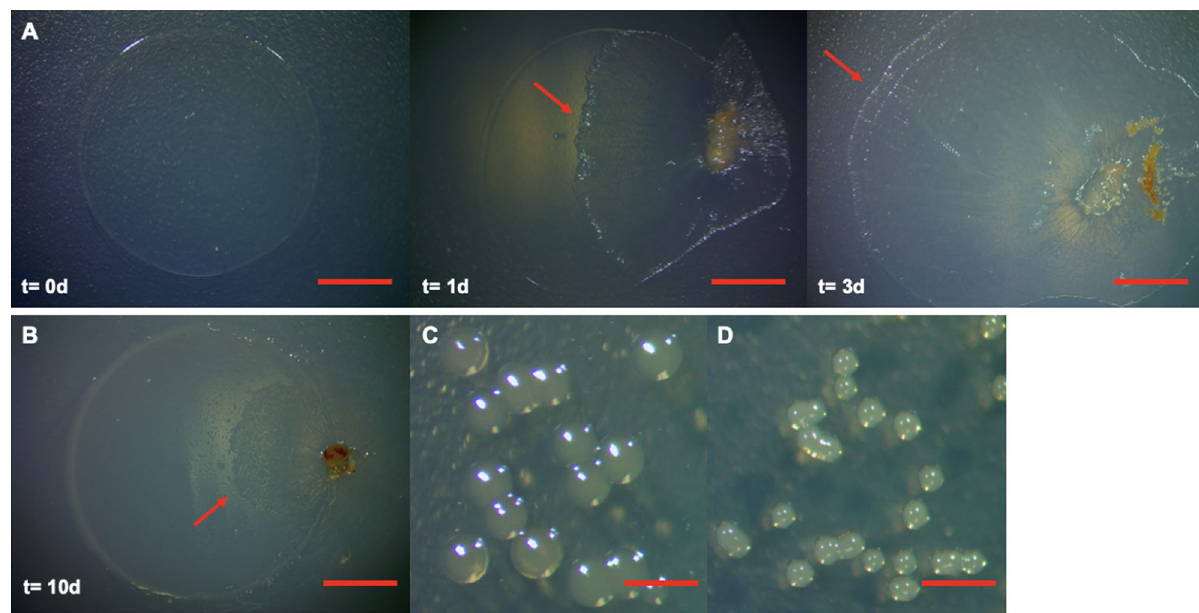
Figure 1. Predation assays resulting in initial observation of survivor P. putida . ( A ) Three day sequence of a C. ferrugineus - P. putida predation assay depicting complete swarming of spotted prey lawns with no visible parent P. putida biomass; red arrows indicate C. ferrugineus swarm edge. Day 0 panel is only P. putida biomass prior to introduction of C. ferrugineus . ( B ) Day 10 of C. ferrugineus - P. putida predation assay depicting incomplete swarming of prey lawns; red arrow indicates C. ferrugineus swarm edge. Comparison of colony sizes of ( C ) parent P. putida colonies and ( D ) survivor P. putida colonies depicting small colony variation. All scale bars depict 1